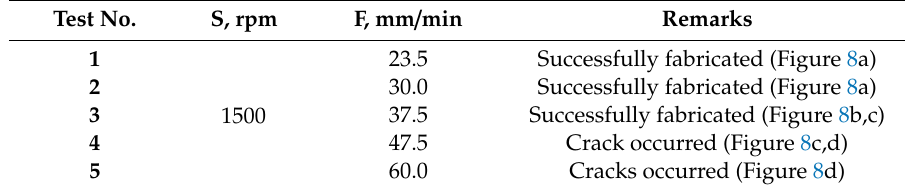
Table 8. Experiments for fabricating 2219Al-Cu lap joint using WC square-pin tool (T D : 22 s).